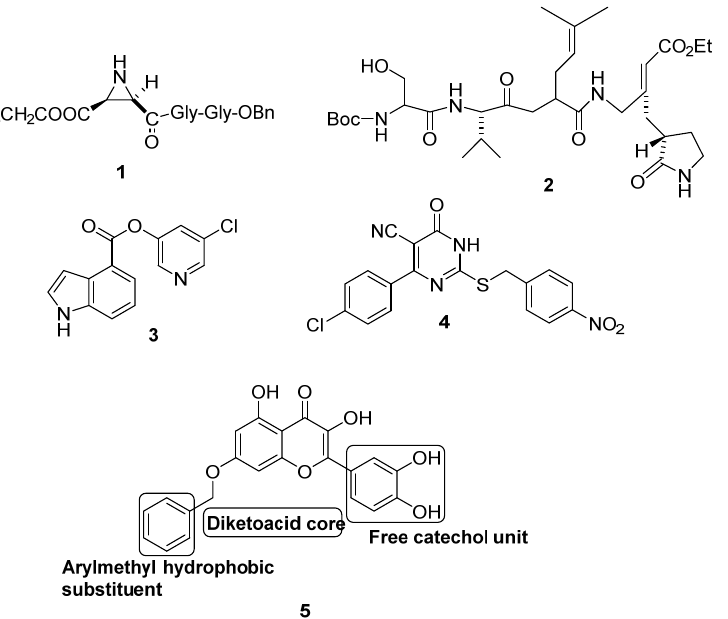
Figure 2. Molecular Targeting of SARS CoV Mpro ( 1 ), SARS CoV 3Clpro ( 2 – 4 ), SARS CoV NTPase/helicase ( 5 ) representing the three key elements essential for binding the aryldiketo derivativies.